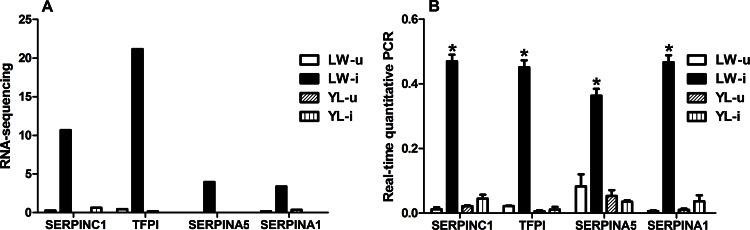
Changes in expression of the DEGs mRNA after PCV2 infection.The mRNA expression of the four DEGs was detected through qPCR. The results of qPCR were similar to the results of RNA-seq. The GAPDH gene was used as reference gene. * P < 0.05.